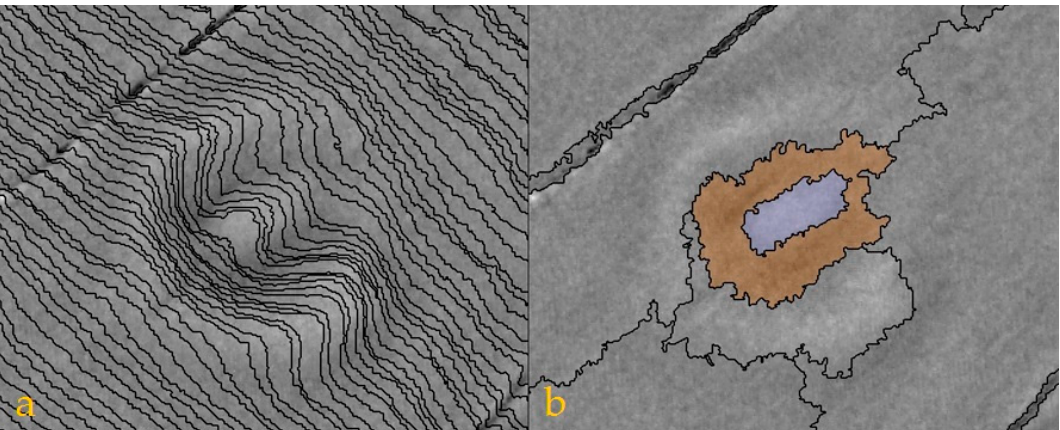
Figure 8. Difference Maps of a highly eroded Motte-and-Bailey castle on a hillside in Warburg with overlaying objects derived from a regular DTM ( a ) and from a Difference Map ( b ) [13,16].